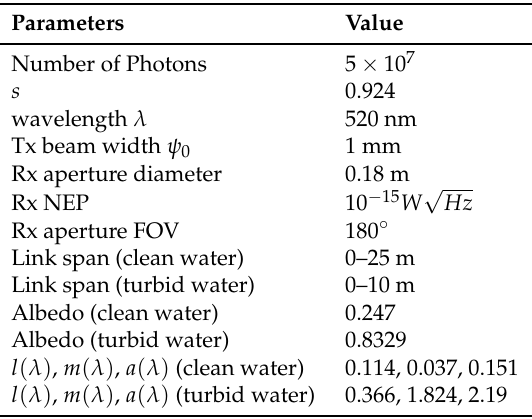
Table 2. Parameters used for